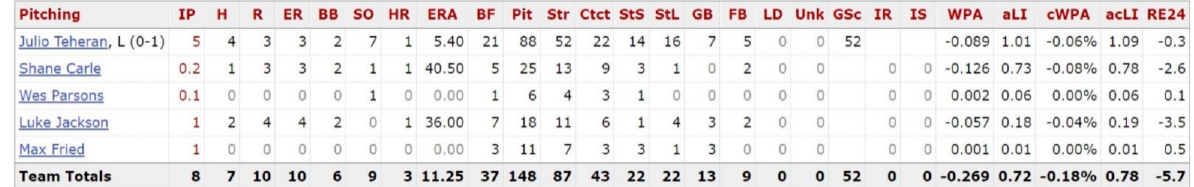
Figure 3. Atlanta Braves pitching statistics.